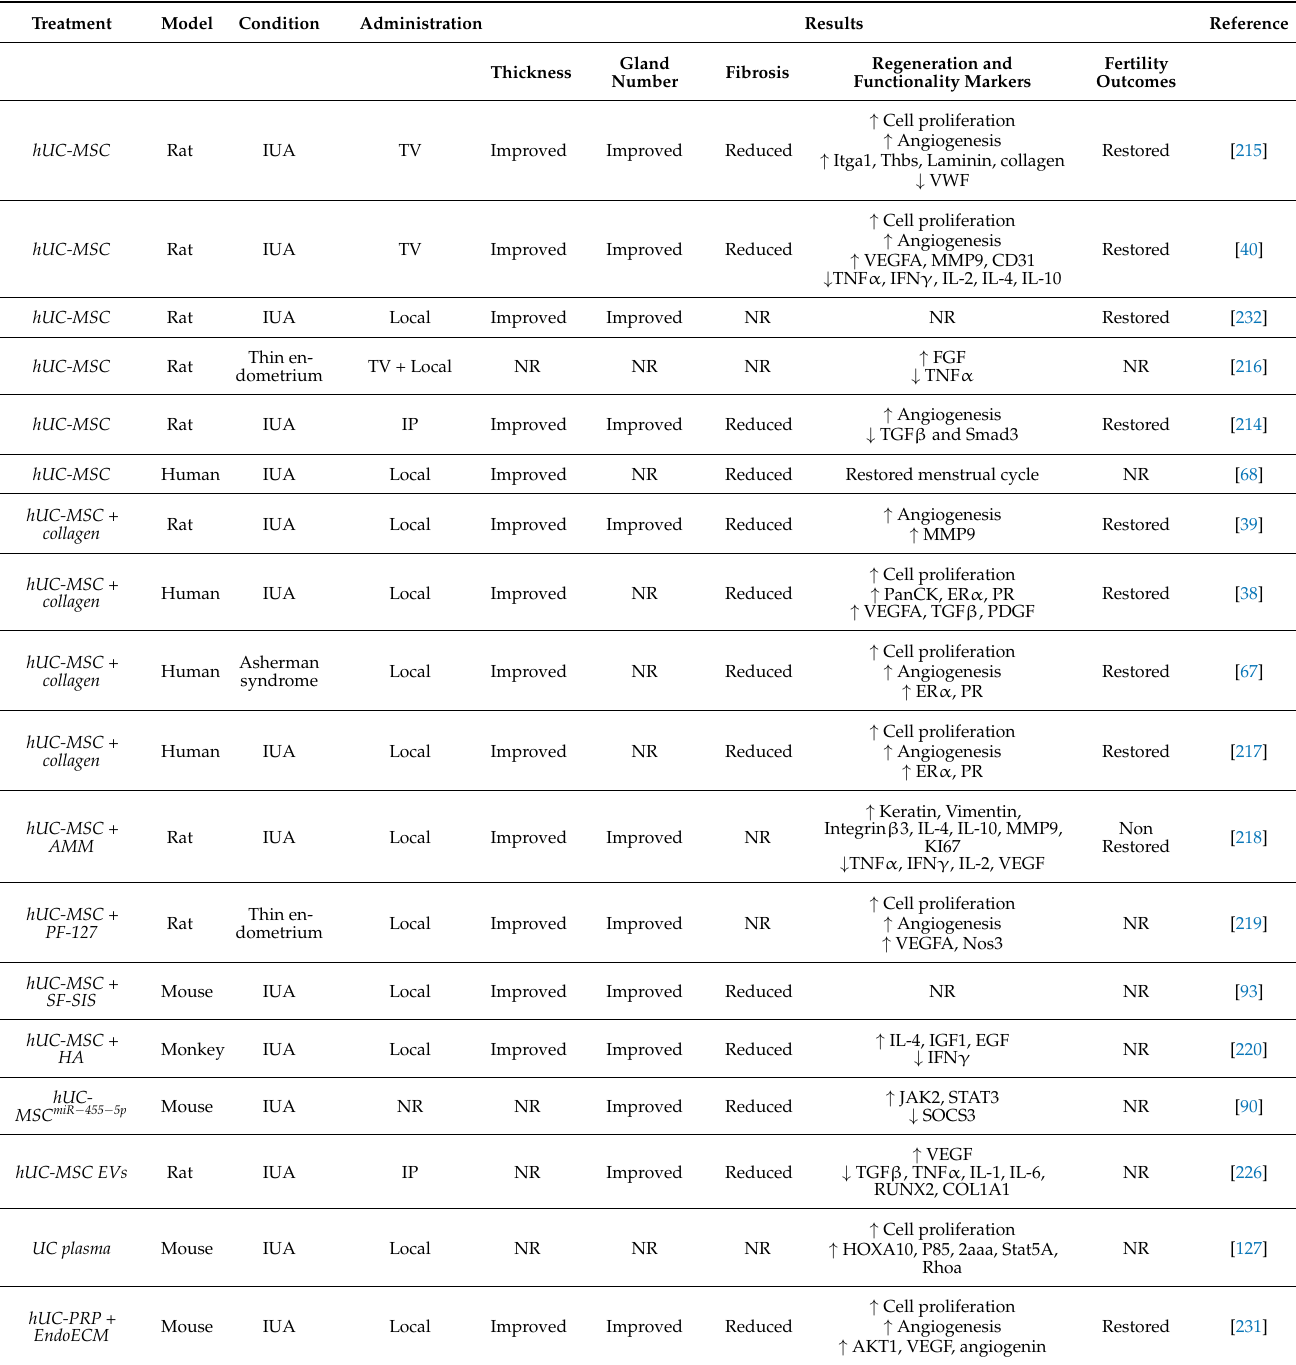
Table 3. Outcomes of studies applying hUC-MSCs or their derivatives (with or without bioengineered scaffolds) to treat endometrial